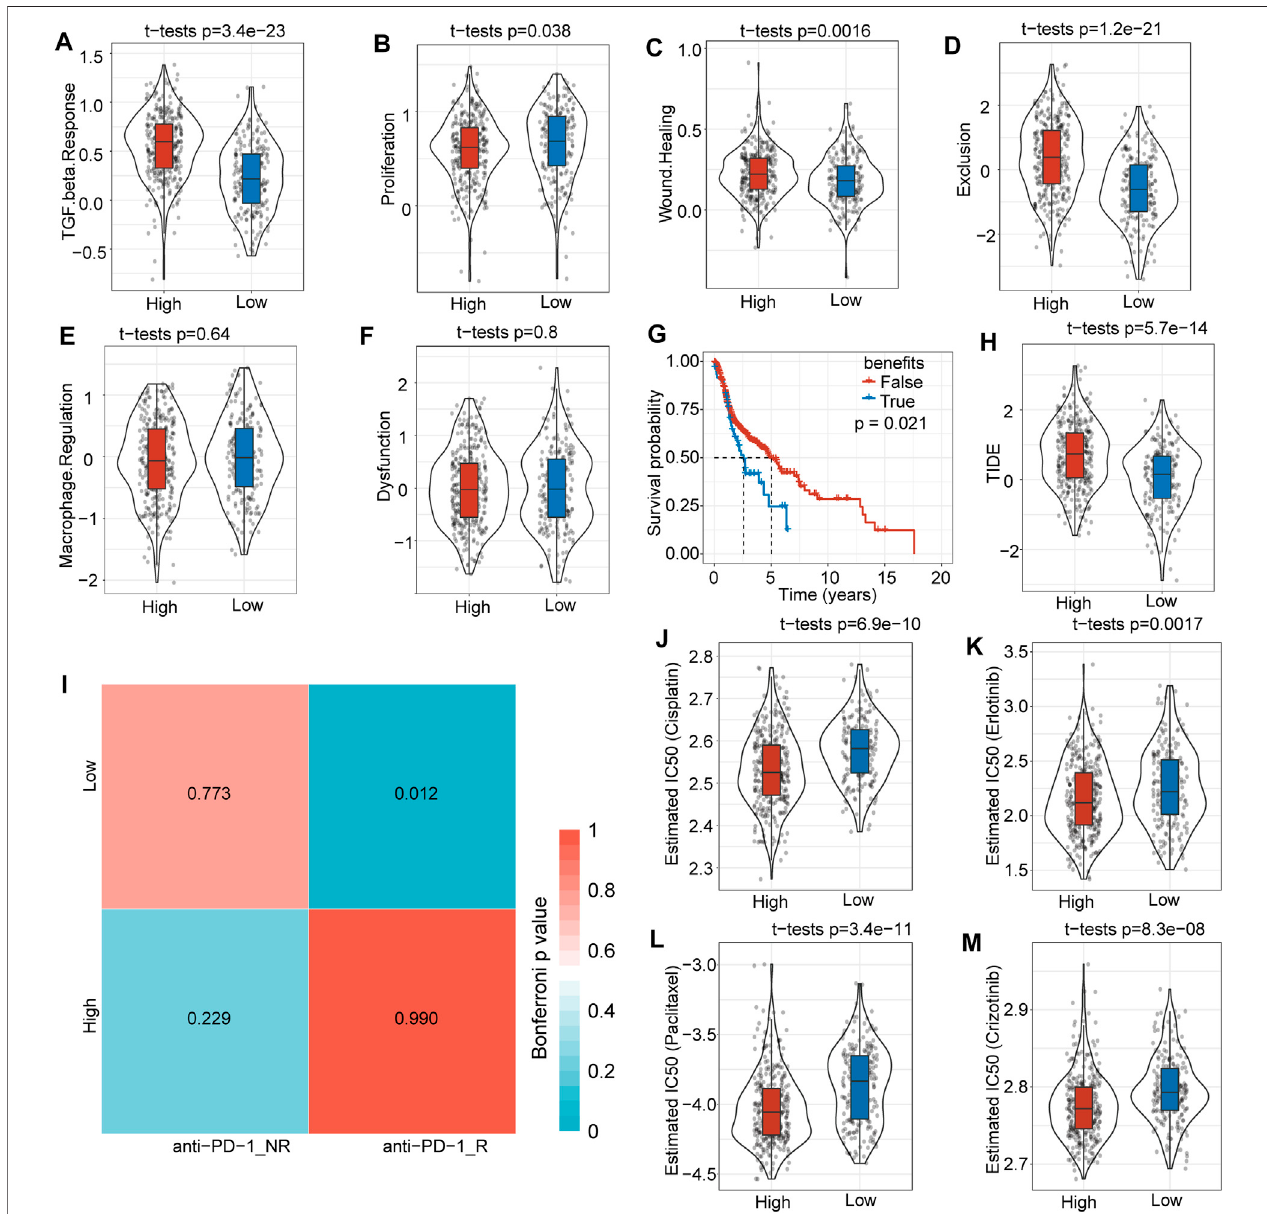
FIGURE 7 | Differences in immunotherapy and clinical ef fi ciency. (A) The TGF- β response was much higher in the high-risk score group than in the low-risk score group. (B) The proliferation score was slightly higher in the high-risk score subgroup. (C) There was no signi fi cant difference in macrophage regulation between the two subgroups. (D) Thewoundhealingscorewashigher inthehigh-risk scoresubgroup. (E) Overallsurvivaltime prediction between trueand falseimmunotherapiesbased onTIDEanalysistools. (F) TheTIDEscorewassigni fi cantlyhigherinthehigh-riskscoresubgroup. (G) Thedysfunctionscorewasnotsigni fi cantlydifferentbetween the twosubgroups. (H) Theexclusion scorewas much higher in thehigh-risk score subgroup. (I) Low-risk score subgroup patients mightbe more sensitive toanti-PD1 immunotherapy. (J) BoxplotsoftheestimatedIC50forcisplatinshowedthatthehigh-riskscoresubgrouphadalowerIC50level. (K) BoxplotsoftheestimatedIC50for erlotinibshowedthatthehigh-riskscoresubgrouphadalowerIC50level. (L) TheboxplotsofestimatedIC50forpaclitaxelshowedthatthehighriskscoresubgrouphad a lower IC50 level. (M) Box plots of the estimated IC50 for crizotinib showed that the high-risk score subgroup had a lower IC50 level.